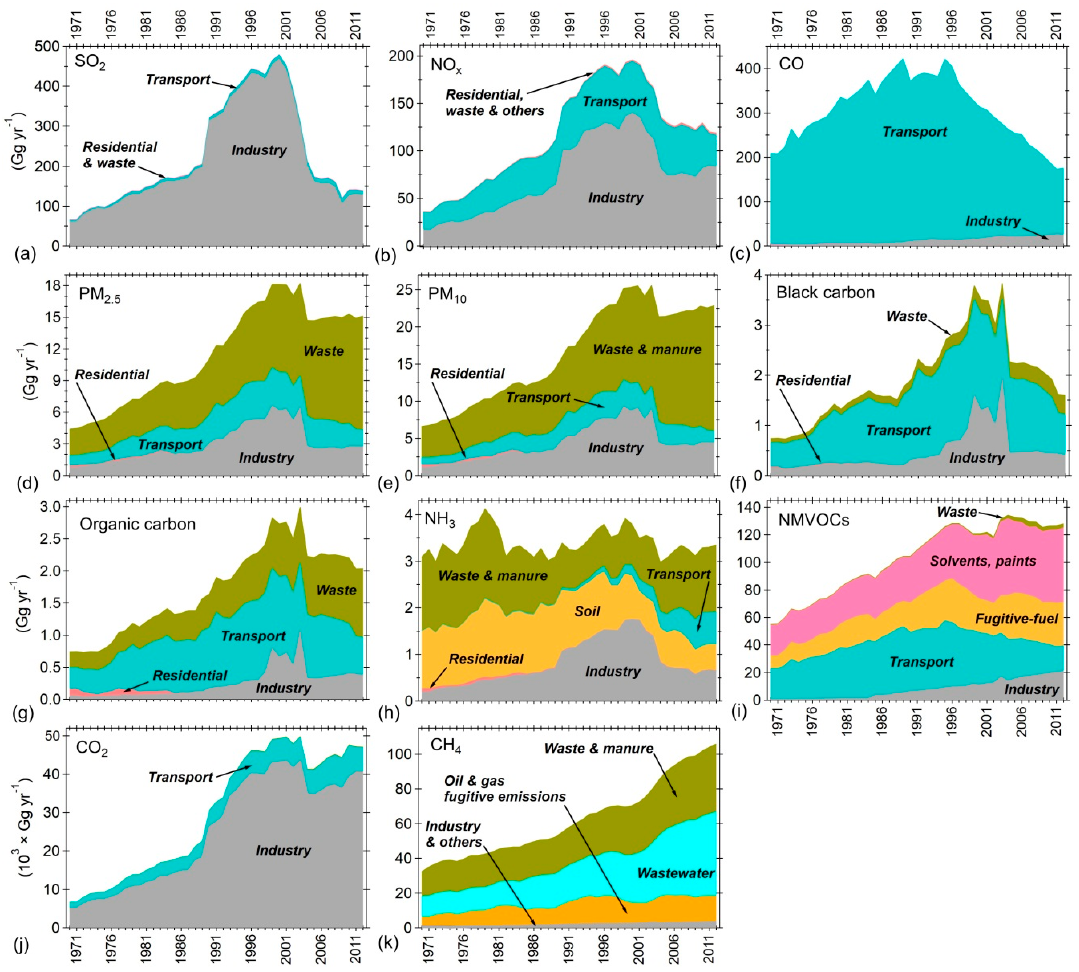
Figure 12. Singapore’s emission time series (1970–2012) by sectors for O 3 precursor gases (CO, NO x , and NMVOCs), acidifying gases (NH 3 , NO x , and SO 2 ), primary particles (PM 10 , PM 2.5 , black carbon, and organic carbon), and greenhouse gases (CO 2 and CH 4 ) as computed by the global air pollutant emissions EDGAR v4.3.2 inventory (Crippa et al., [135]; Janssens-Maenhout et al., [136]). The emissions presented here are lumped in major sectors; the contributions from specific sectors can be retrieved from EDGAR database [137].